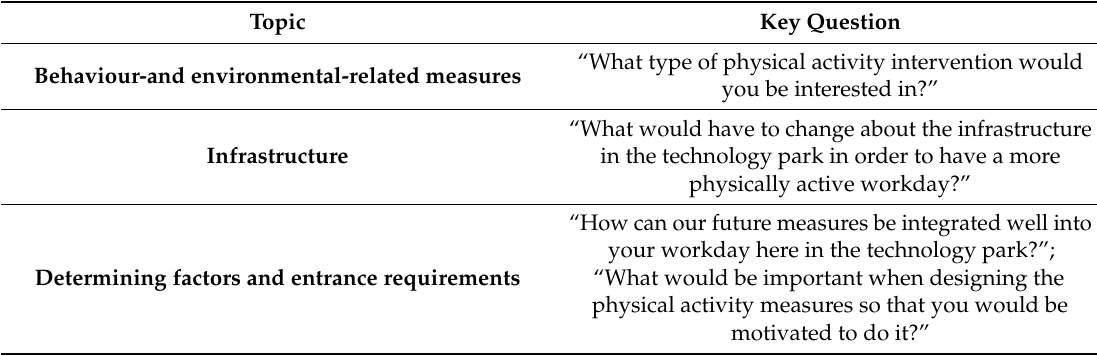
Table 2. Topics and key questions of the discussion guide